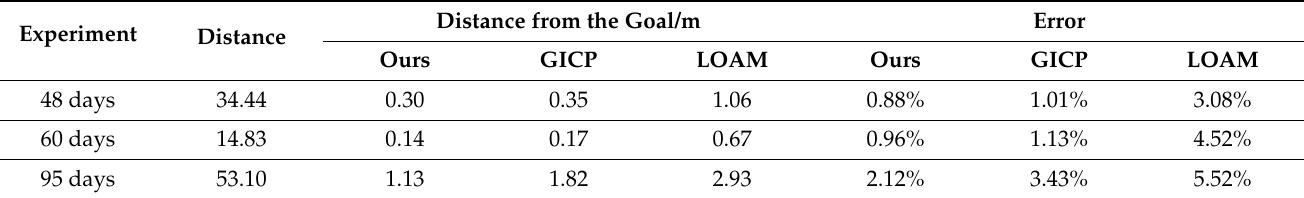
Figure 10. Trajectories of benchmark methods in 48 days maize field data. In the figure, “Ground Truth” is simply represented as GT, “Starting Point” as SP, “The end of our method” as OE, “The end of GICP” as GE, and “The end of our method” as LE. Table 4. Distance and relative error of trajectory.